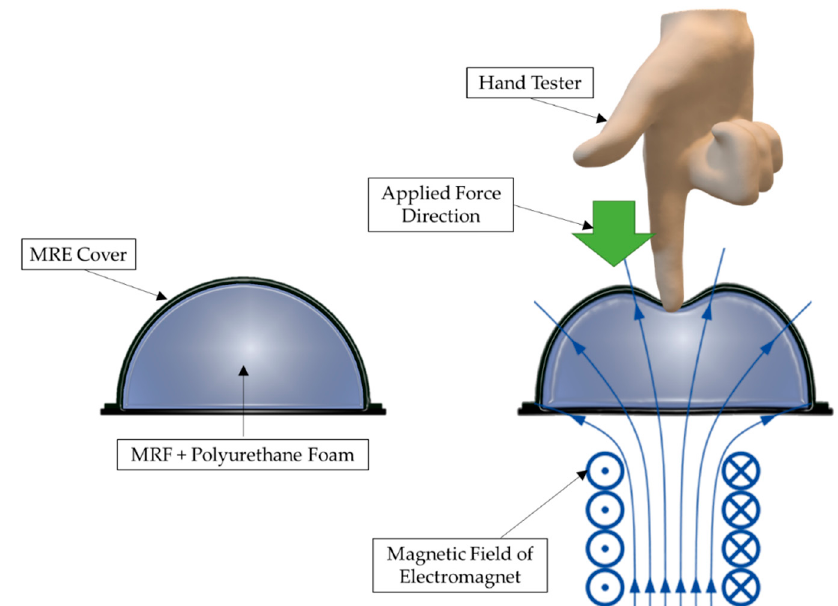
Figure 2. Squeeze mode of MRTTC.